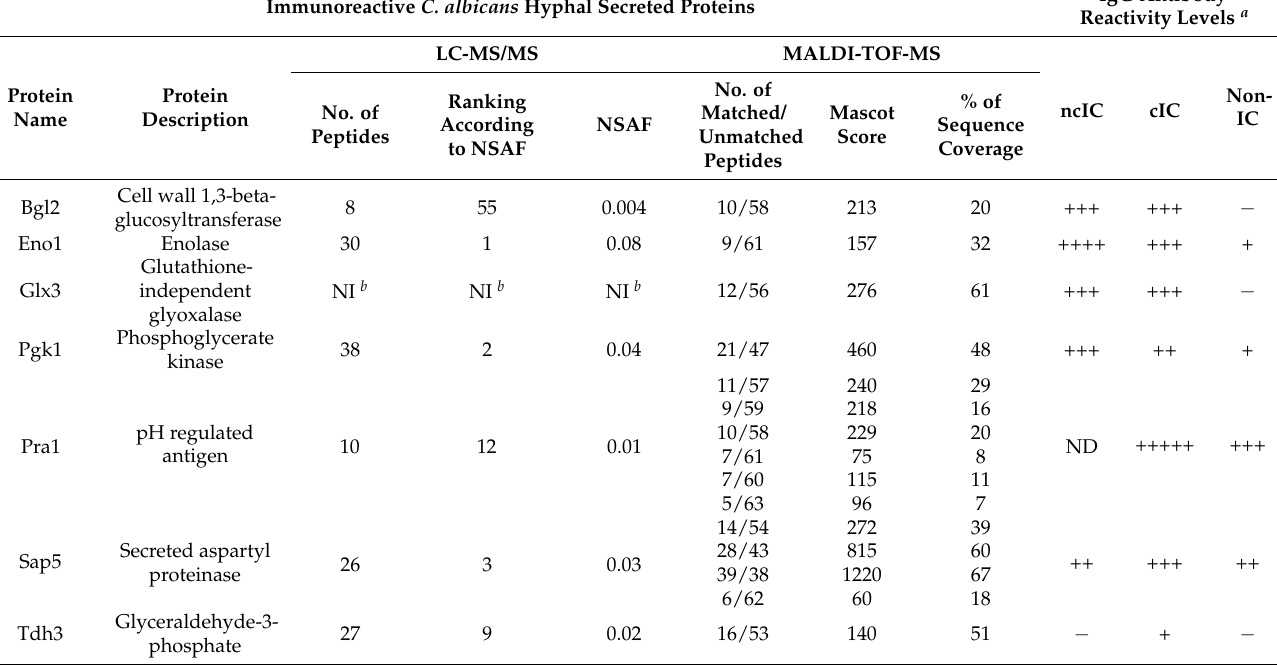
Table 2. Recognition patterns of C. albicans hyphal secreted proteins by serum pools from ncIC, cIC and non-IC